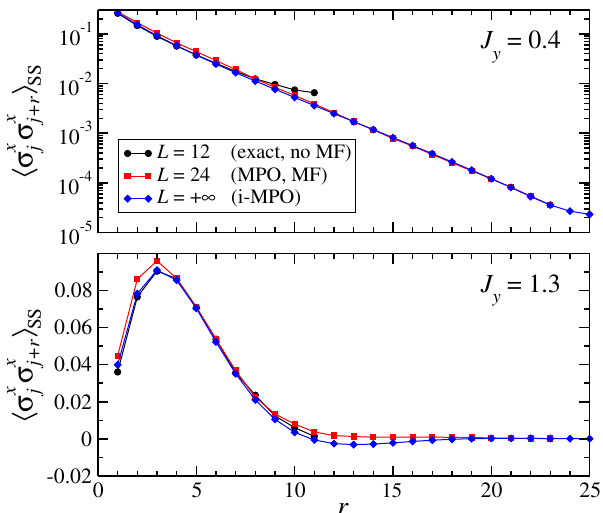
FIG. 7. Spatial decay of the correlation functions h σ x j σ x j with the distance r . Correlators have been chosen in a symmetric way with respect to the center of the chain. In the upper panel, J 0 . 4 (left peak in Fig. 5), while in the lower panel, J y ¼ (right peak in Fig. 5). The various data sets correspond to different system sizes: Results for L ¼ 12 have been obtained for systems with PBC by means of RK integration or the QT approach to the master equation; those for L ¼ 24 are, with MPO, used to simulate OBC and combined with the CMF; the thermodynamic limit L → ∞ (diamonds-solid blue lines) has been addressed with a translationally invariant i-MPO method. The other parameter values are set as in Fig. 5.